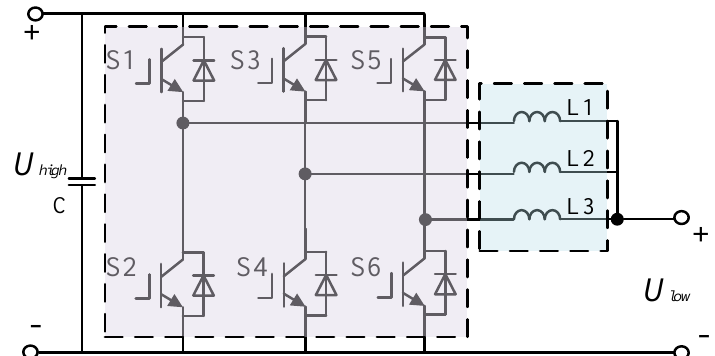
Figure 1. The basic structure of HESS for DEPA.